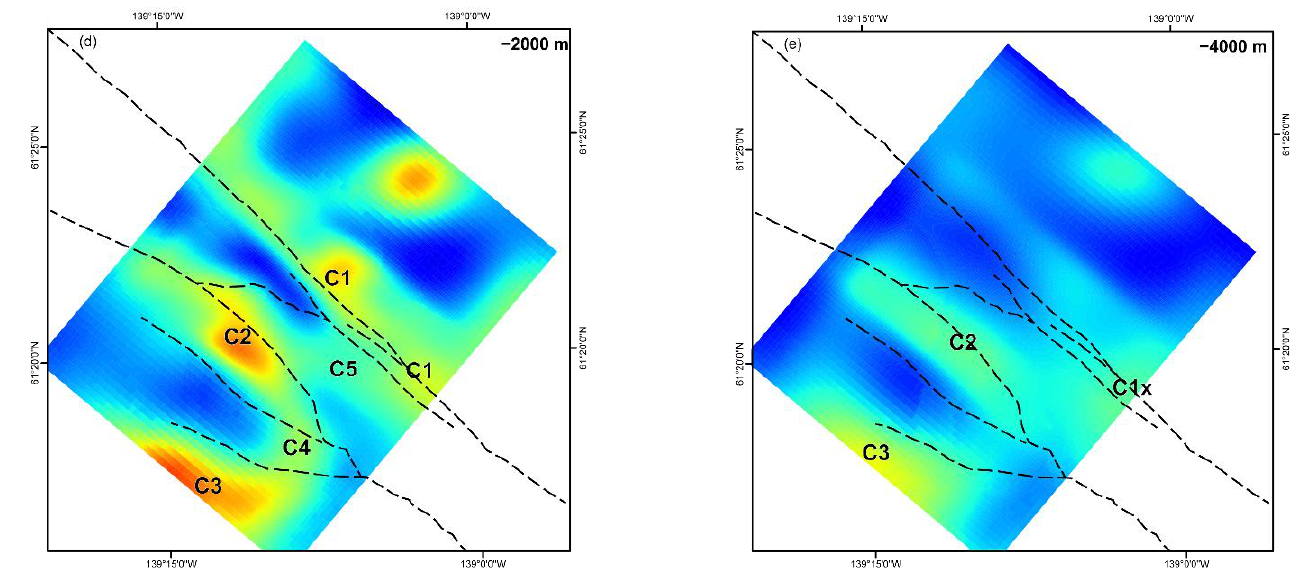
Figure 5. ( a ) Location of mesh and cross-sections from Figure 6 over DEM. Horizontal plan view maps of the preferred 3D electrical resistivity model at selected elevations of: ( b ) −500 m depth; ( c ) −1000 m depth; ( d ) −2000 m depth; and ( e ) −4000 m depth. The conductors (C1, C1x, C2, C3, C4, C5) and resistors (R1, R2) are explained in the text. Faults plotted as dashed lines.